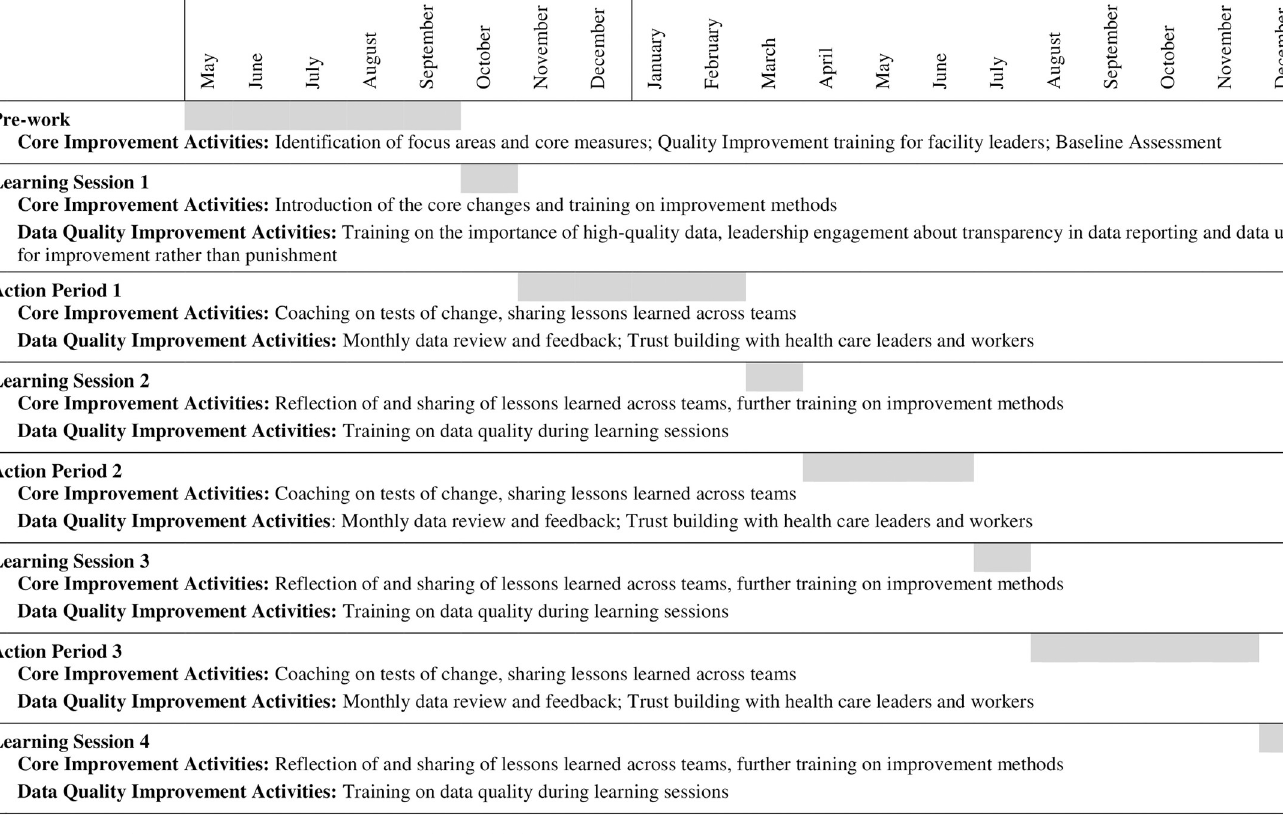
Fig 1. Summary of the core improvement activities and embedded data quality improvement activities.